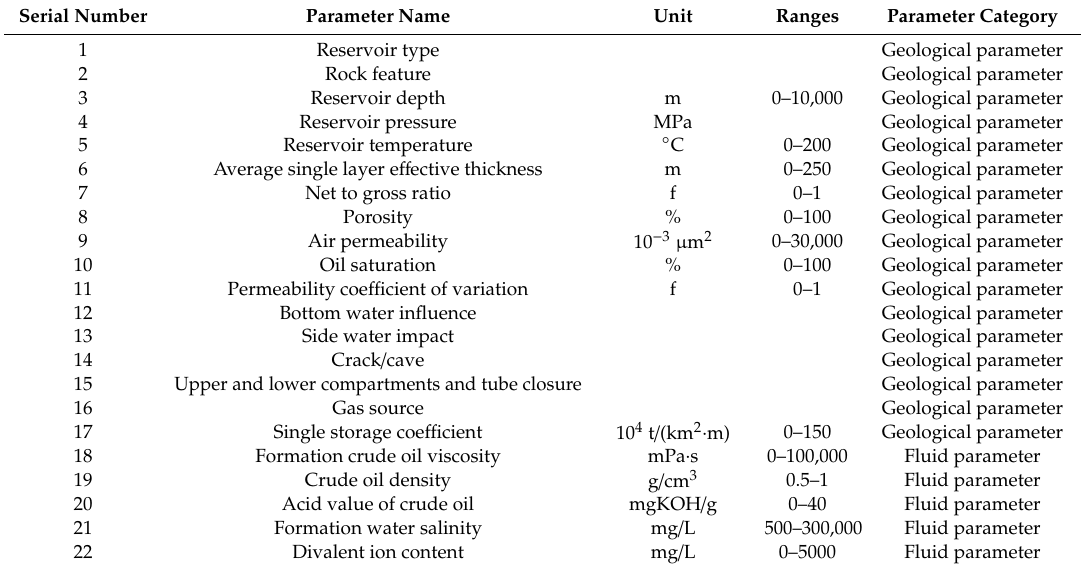
Table 1. Summary of the screening